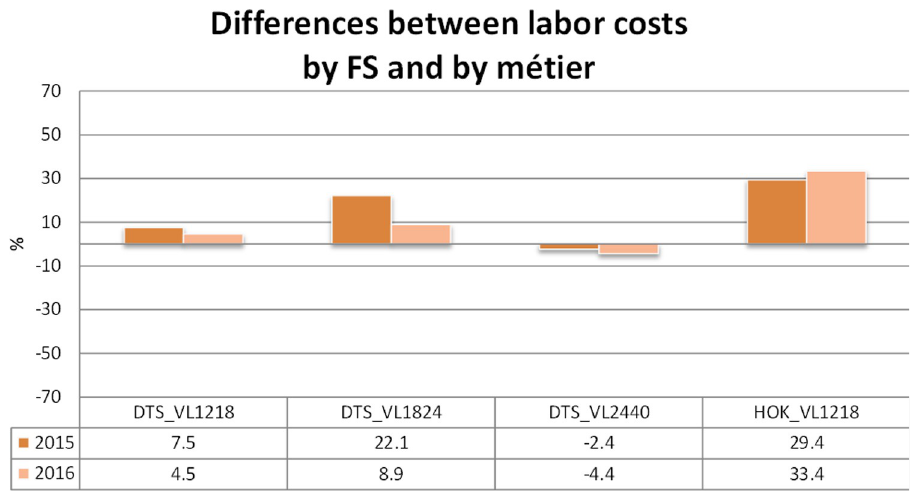
Fig 7. Differences between the labor costs by fleet segment and by me ´